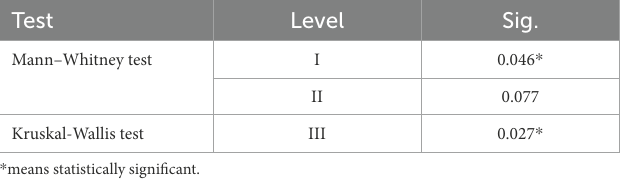
TABLE 5 Pairwise